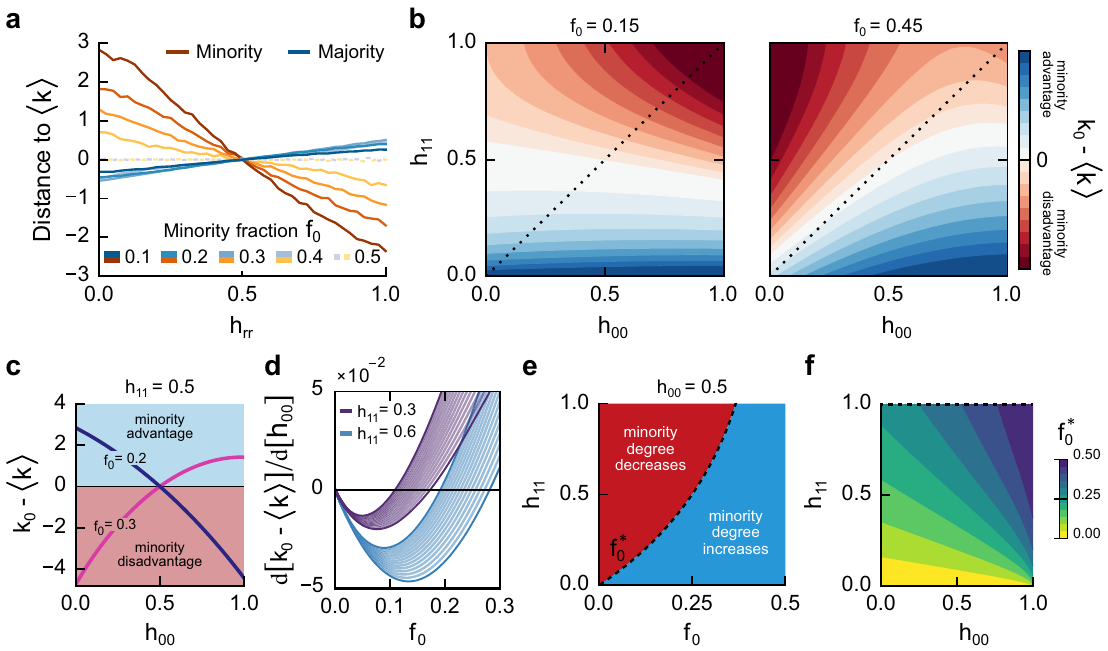
Fig. 3 The minority (dis)advantage in networks. a The distance of groups' average degree to the overall average degree ( z score) with different minority fraction f 0 and at varying levels of symmetrical mixing (i.e., h 00 = h 11 = h rr ). The minority members have a degree advantage or disadvantage if the system is, respectively, at a heterophilic ( h rr < 0.5) or homophilic ( h rr > 0.5) regime. b The distance of the minority group degree to the overall average degree, denoted k 0 − 〈 k 〉 , at different levels of asymmetrical mixing (i.e., h 00 ≠ h 11 ). The majority mixing h 11 explains much of the variance of k 0 − 〈 k 〉 . c The variation of k 0 − 〈 k 〉 with changes in the minority mixing h 00 , with fi xed h 11 = 0.5 and different minority fraction f 0 . The minority mixing can have opposite impacts on degree inequality depending on the minority fraction, which suggests a qualitative transition in the system. d The derivative of k 0 − 〈 k 〉 as a function of f 0 . The zero of this function represents the critical minority fraction, denoted f (cid:3) , at which the qualitative transition occurs. In the plot, same-color curves 0 represent varying levels of minority mixing, from h 00 = 0 to h 00 = 1. e Two regimes delineated by f (cid:3) , with initial h 00 = 0.5. These regimes mean that the 0 minority group degree may either increase or decrease with a raise of h 00 . f The parameter space of critical minority fraction. Given h 00 , the upper limit of f (cid:3) , denoted f (cid:3) (dashed line), represents the smallest minority size allowing higher minority homophily without decreasing group average degree, regardless 0 0 of the majority